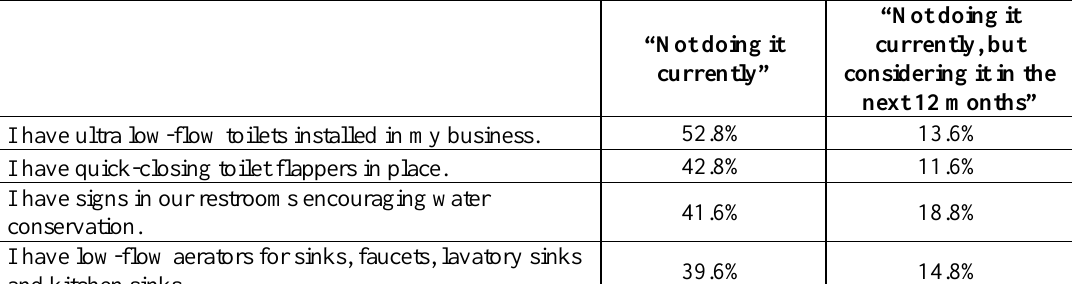
Table 5: Water conservation measures